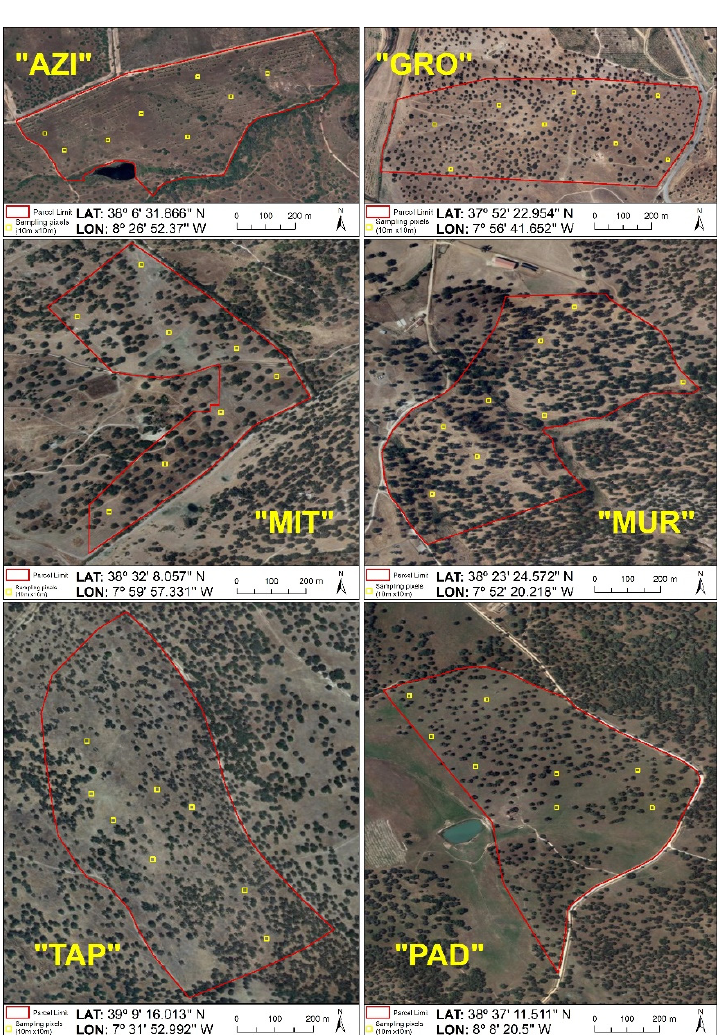
Figure 6. Eight “10 m × 10 m” sampling area without trees georeferenced in each farm.